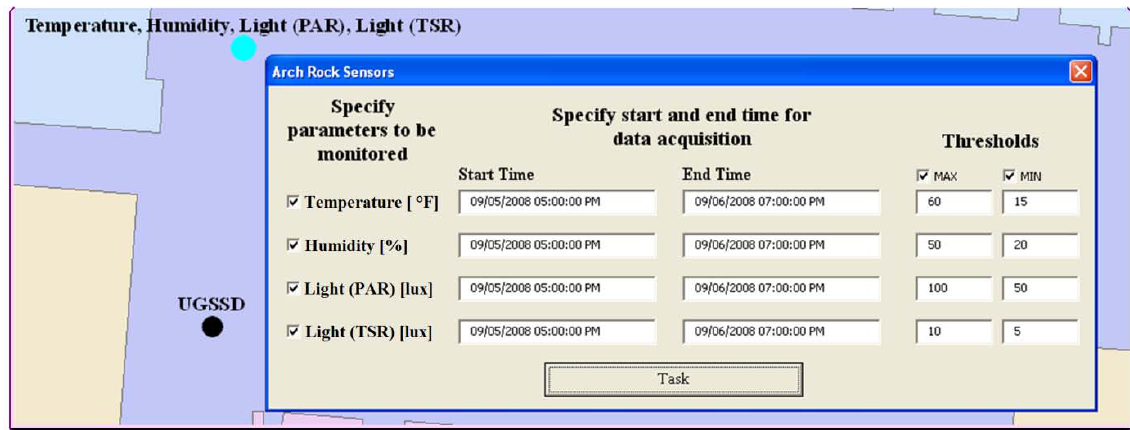
Figure 9. GIS interface for setting Arch Rock sensors tasking parameters. The interface requires the following inputs to be specified by the user: (i) parameters to be monitored by the sensor node; (ii) start time and end time for the data monitoring interval; and (iii) alarm thresholds for every parameter specified as maximum and minimum acceptable average values. The sensor state is represented by the symbology on the